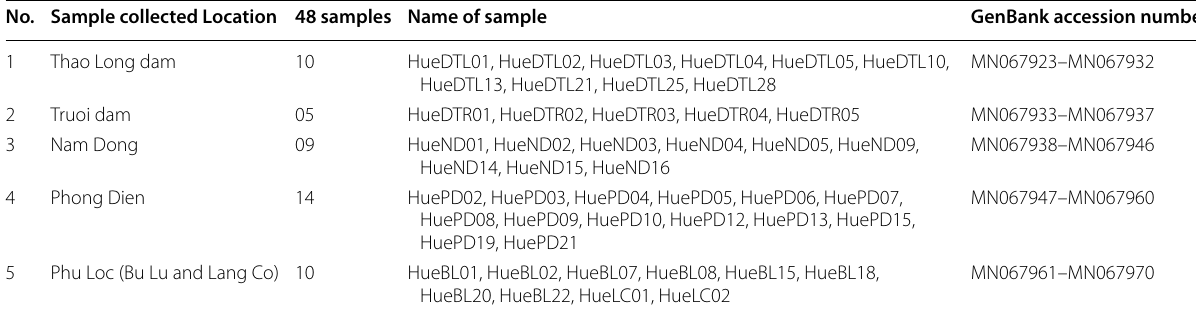
Table 1 Location, number, and codes of Aguilla marmorata used in the study